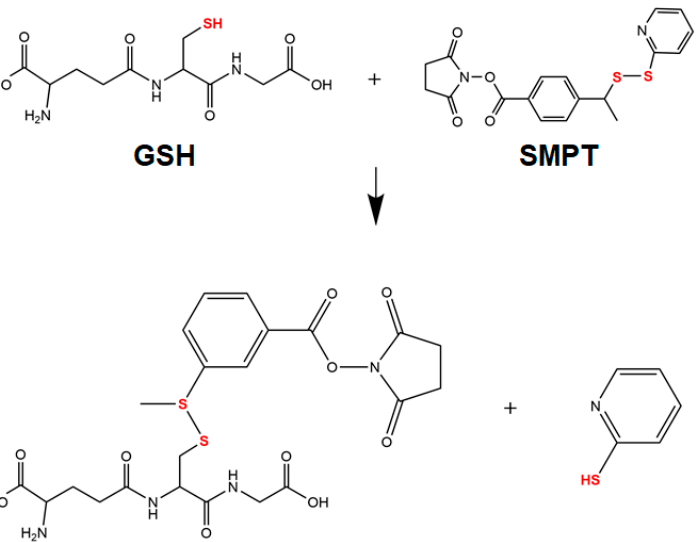
Figure 6. Representation of thiol-disul fi de exchange reaction between glutathione (GSH) and SMPT crosslinker.